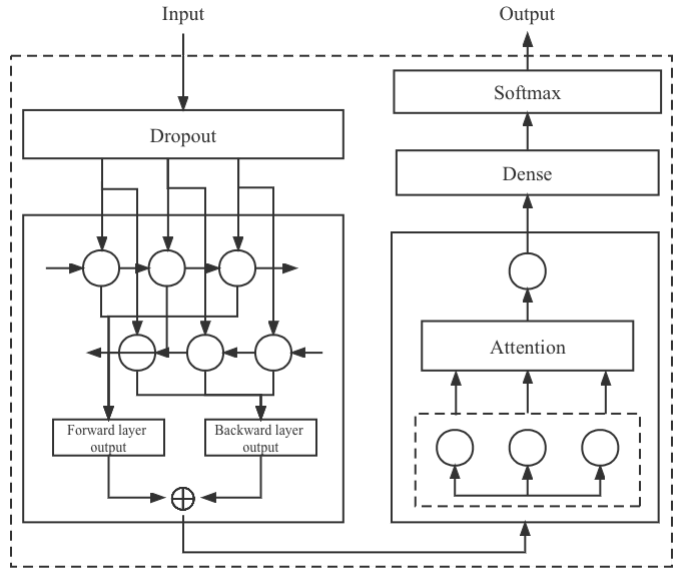
Figure 7. Model structure of